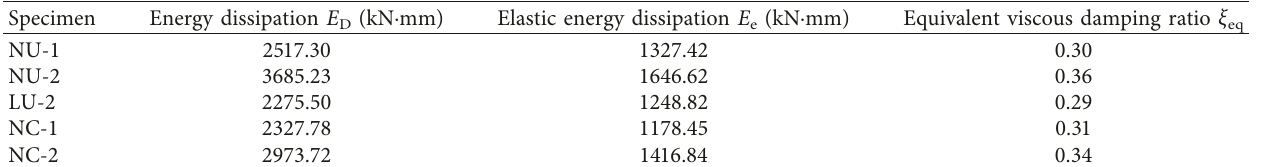
Table 6: Equivalent viscous damping coefficient of